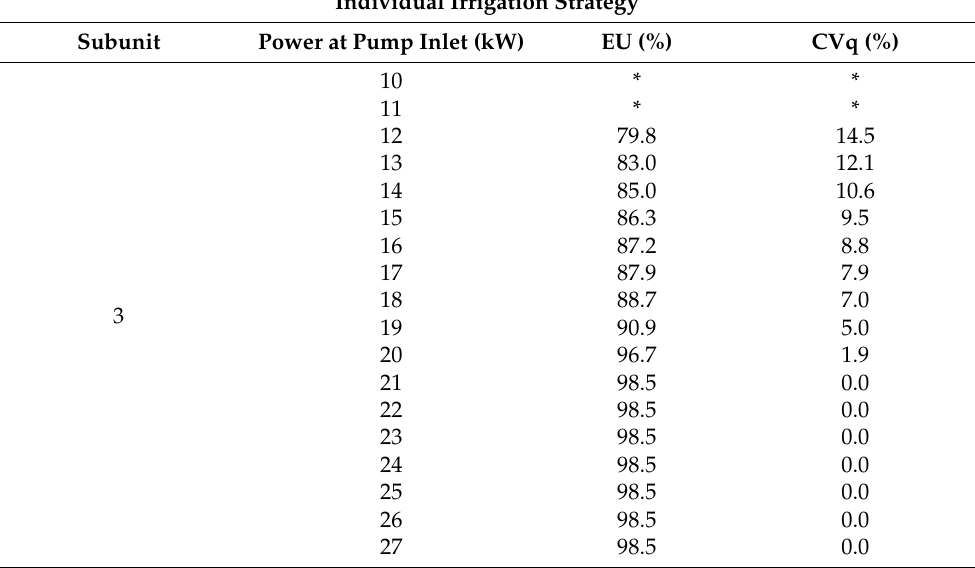
Table 2. Individual irrigation